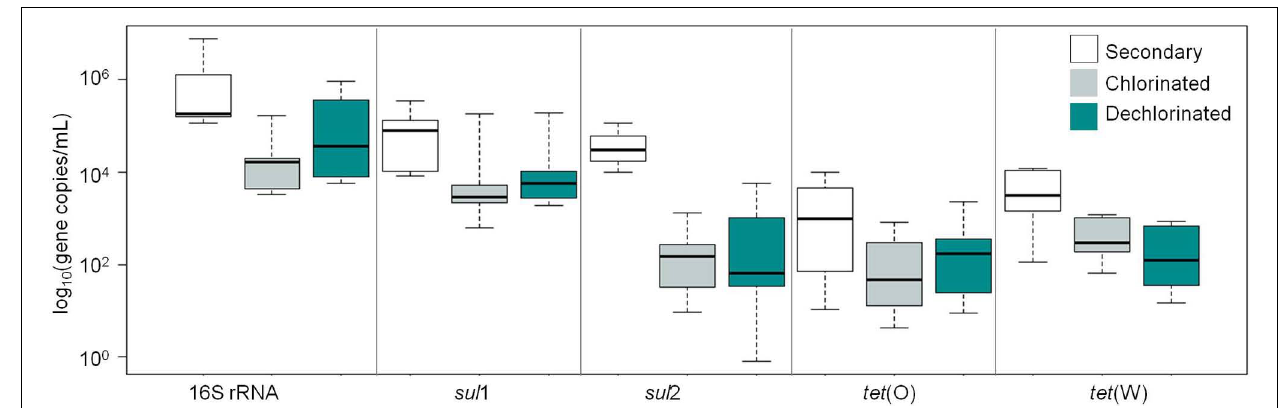
FIGURE 5 | Censored boxplot of 16S rRNA genes, sul 1, sul 2, tet (O), and tet (W) gene copies per milliliter in secondary (no fill), chlorinated (gray), and dechlorinated (blue) domesticWWTP effluents applied in the batch (2–4 L 0. 22 μ m filtered) and periodic (60 mL freeze-dried) irrigation study ( n = 6 tet genes, 7 sul and 16S rRNA genes).